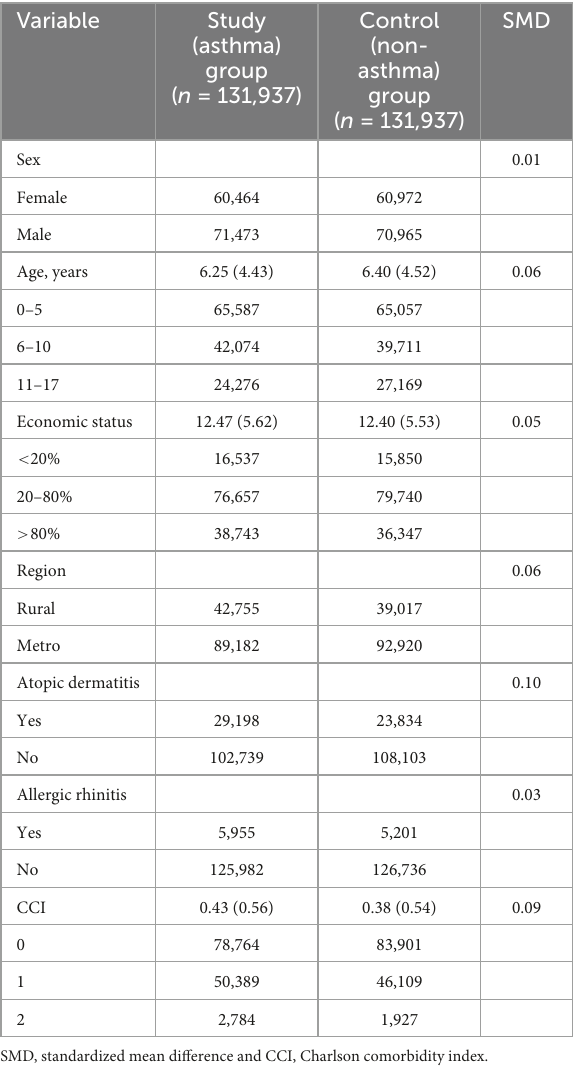
TABLE 1 Demography of asthma and non-asthma groups (Study